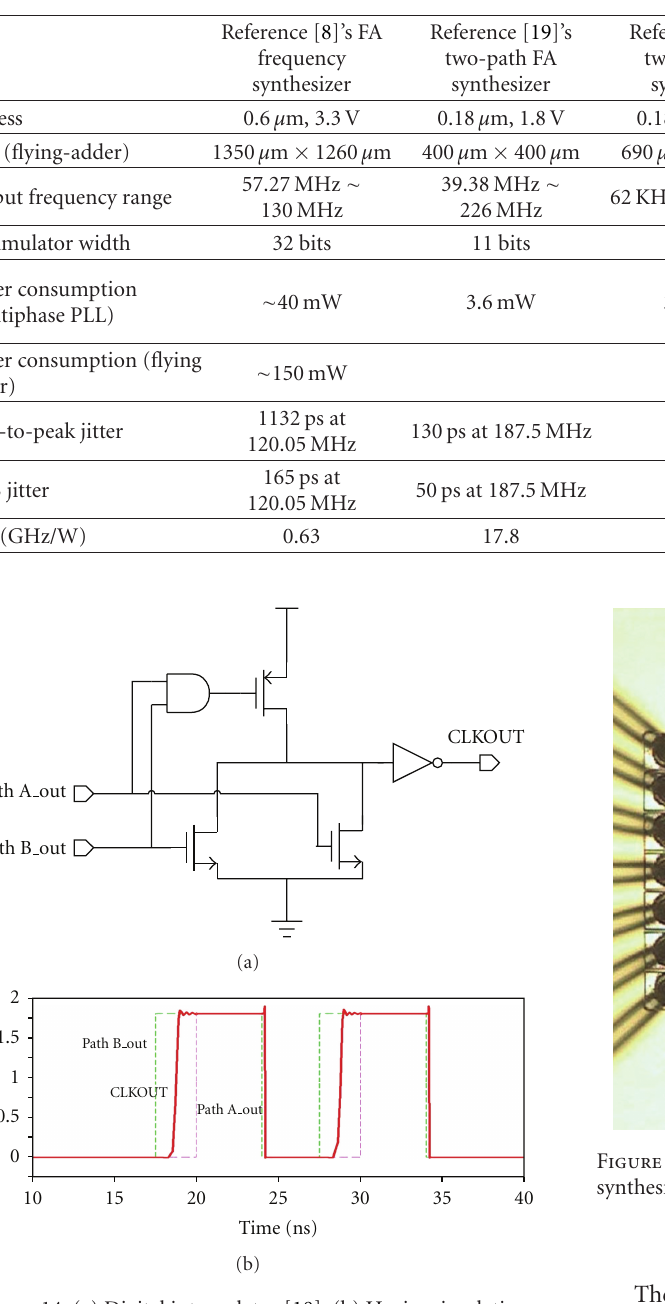
Figure 14: (a) Digital interpolator [18], (b) Hspice simulation.